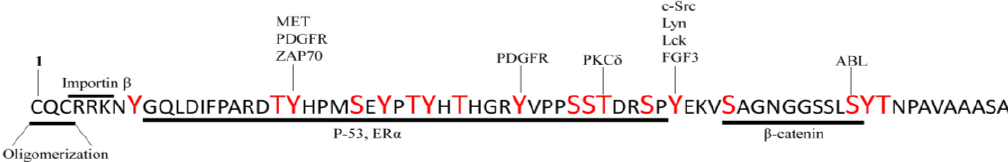
Figure 7. 72 amino-acid sequence of the MUC1-C cytoplasmic domain. Amino acids in large, red font have been reported as phosphorylation sites and kinases are indicated. The CQC motif is necessary for MUC1-C oligomerization and the RRK motif is necessary for MUC1-C binding to importin β and targeting to the nucleus. Also highlighted is the β -catenin, p53 and estrogen receptor (ER) α binding sites.